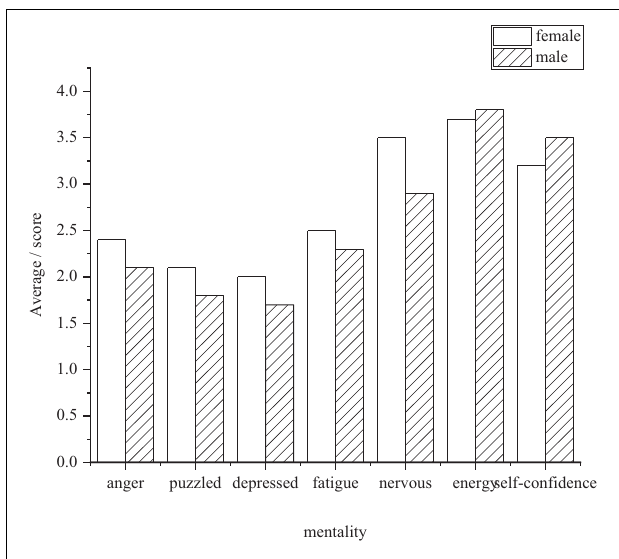
FIGURE 6 | Psychological states of boys and girls participating in physical exercise.